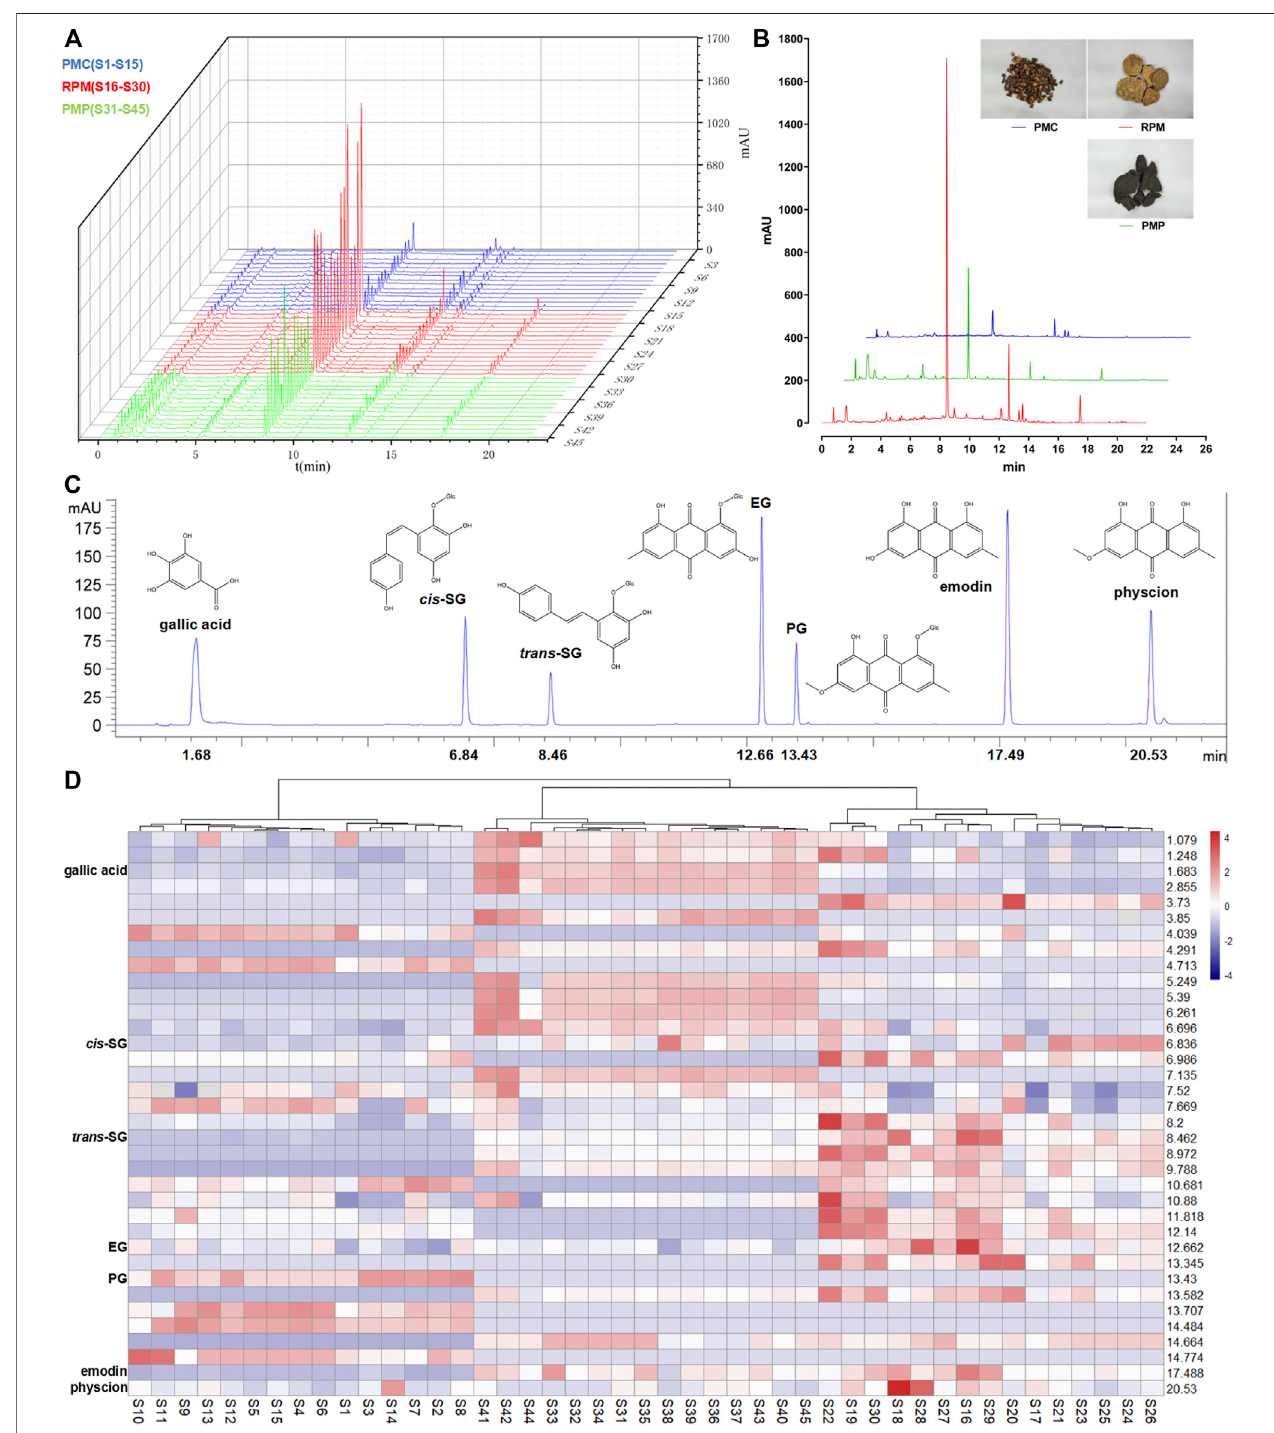
FIGURE2| Comparison ofPMC,RPM, andPMPinchemicalcharacteristics. (A) Chromatograms forwaterextractsfrom 15batchesofPMC,RPM,and PMP. (B) Comparison of the established fi ngerprints. (C) Chromatogram of a mixture of reference compounds. (D) HCA heat-map for 15 batches of PMC, RPM, and PMP. Each colored cell corresponded to a peak area, with samples in rows and retention times in columns.